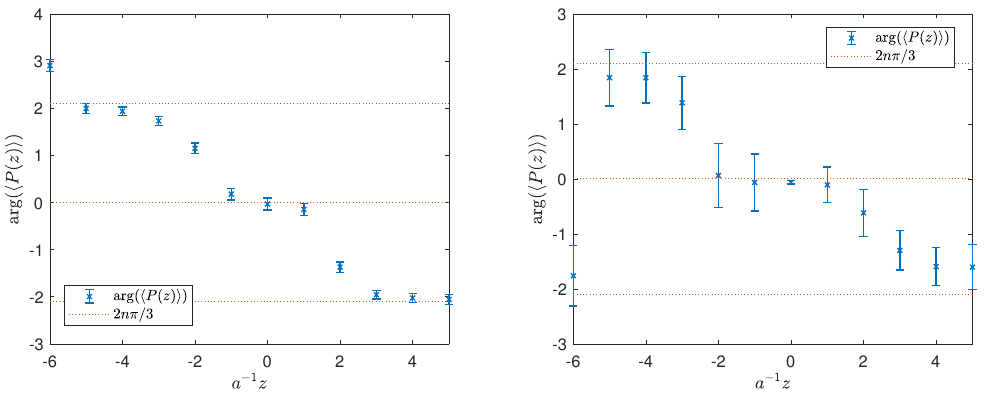
Figure 21 . arg ( h P ( z ) i ) at a 2 eE z = π/ 12 for β = 5 . 3 (the left panel) and β = 5 . 38 (the right panel).